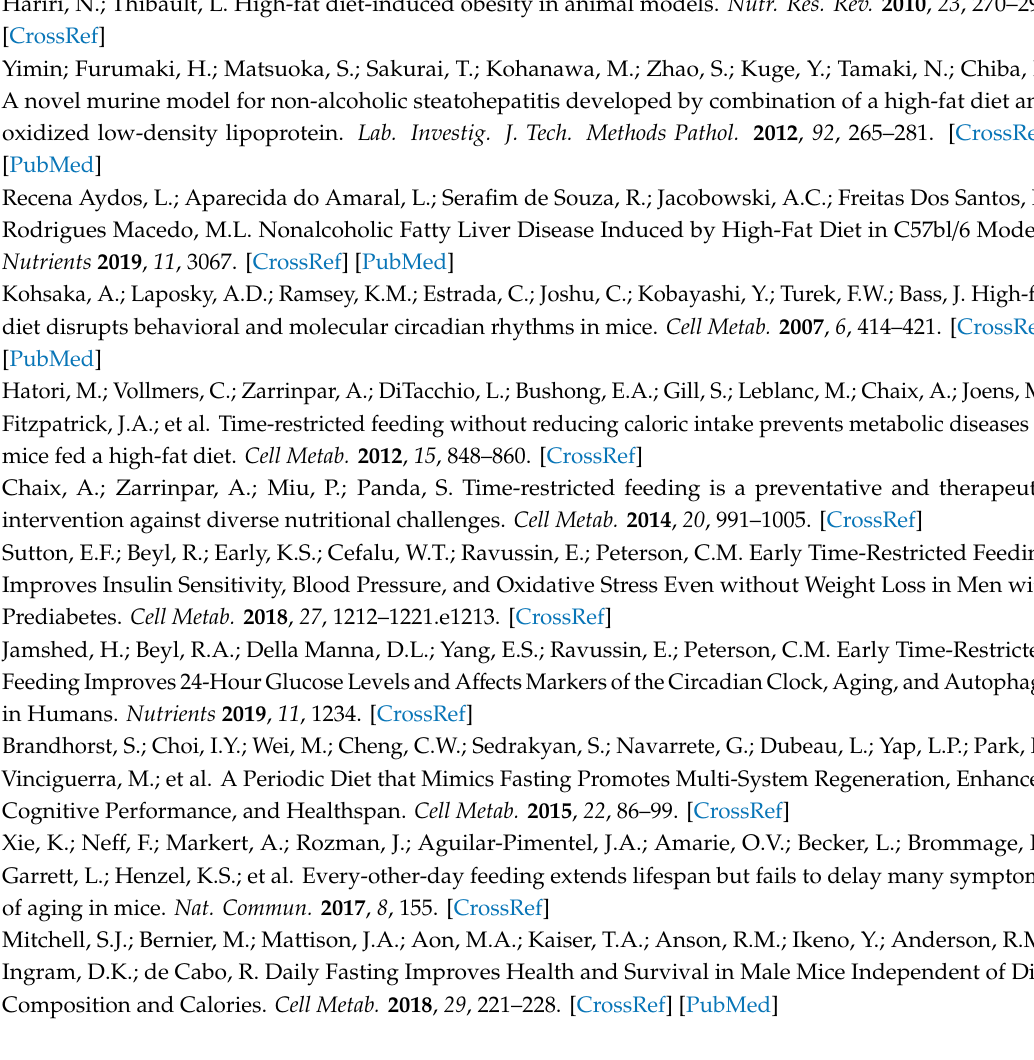
Figure S1: Cumulative food intake, brain weight, survival curves, bone density, and heatmap of blood biomarkers, Figure S2: Results of tail suspension test, open field test, rotarod test, and inverted grid test, Figure S3: Hierarchical cluster analysis and PCA analysis about hepatic gene expressions, Table S1: Information and results of quantitative PCR. Table S2: Results of blood